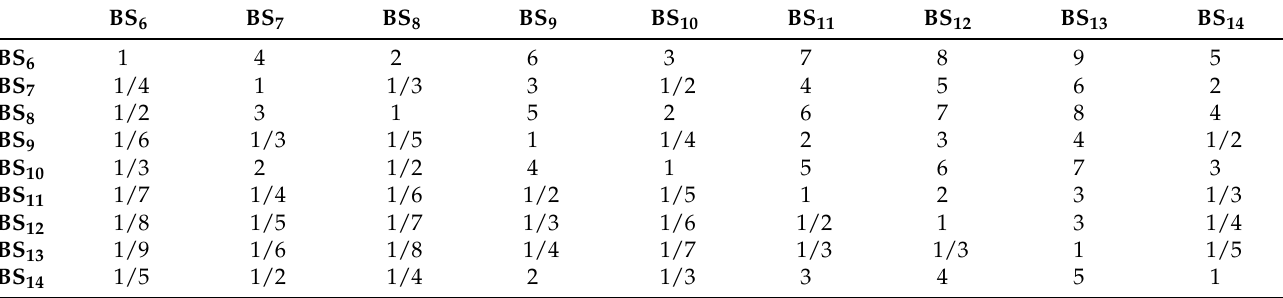
Table A15. The pairwise comparison matrix Admin _ C 3